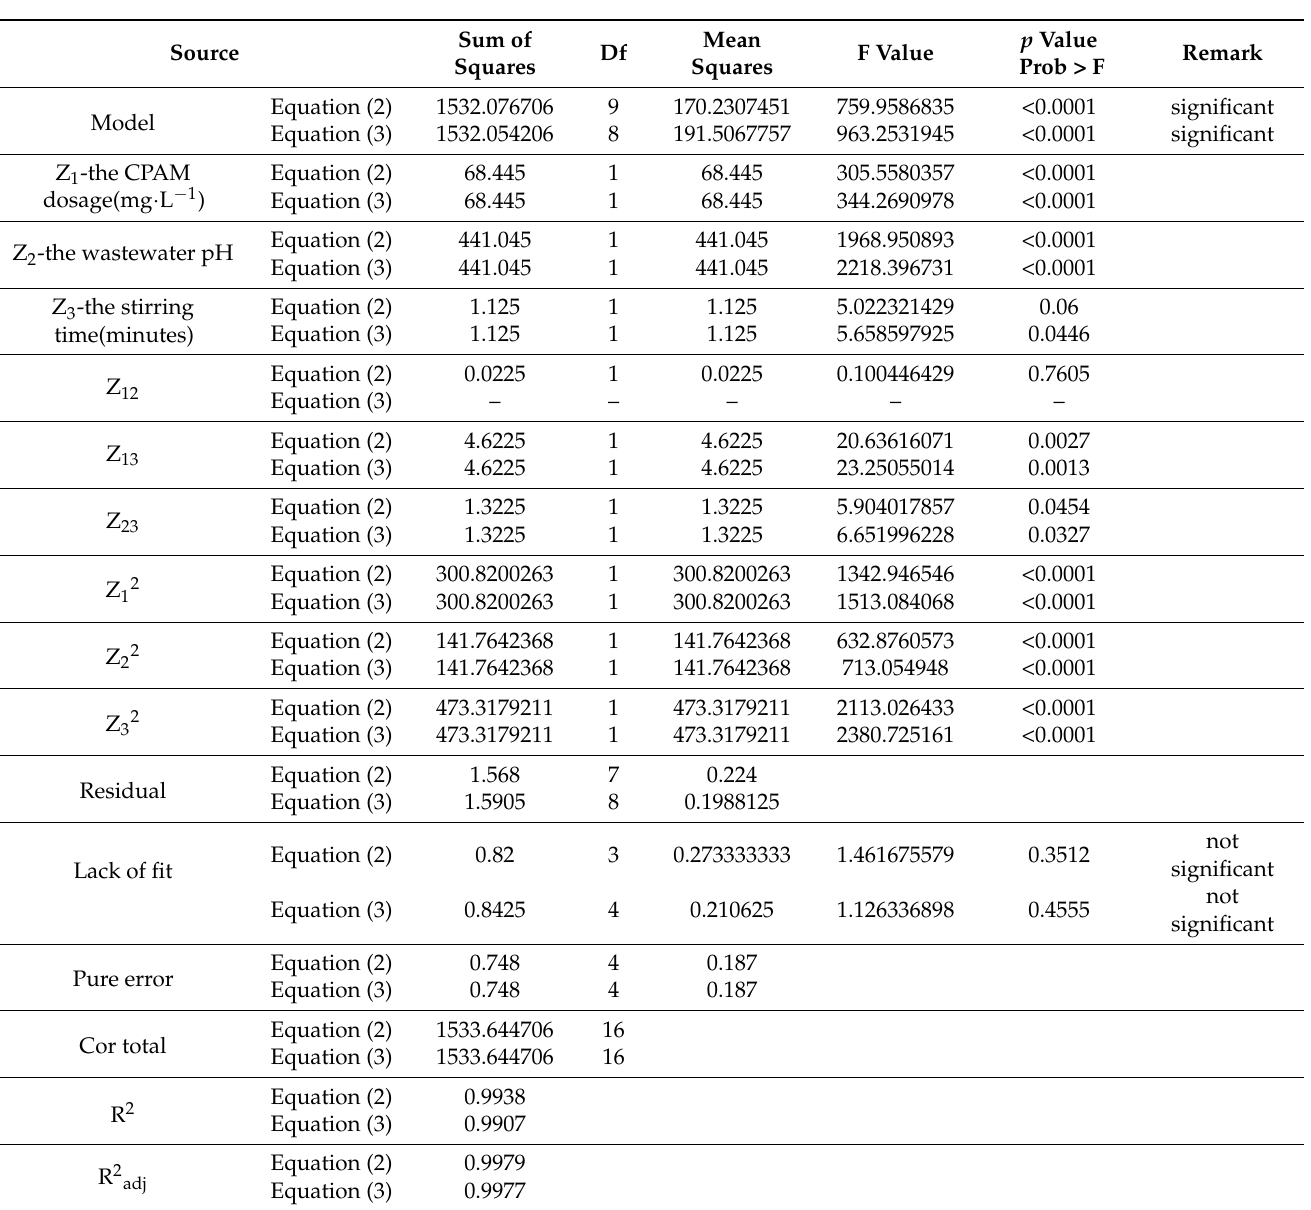
Table 4. ANOVAs for the response surface of Equations (2) and